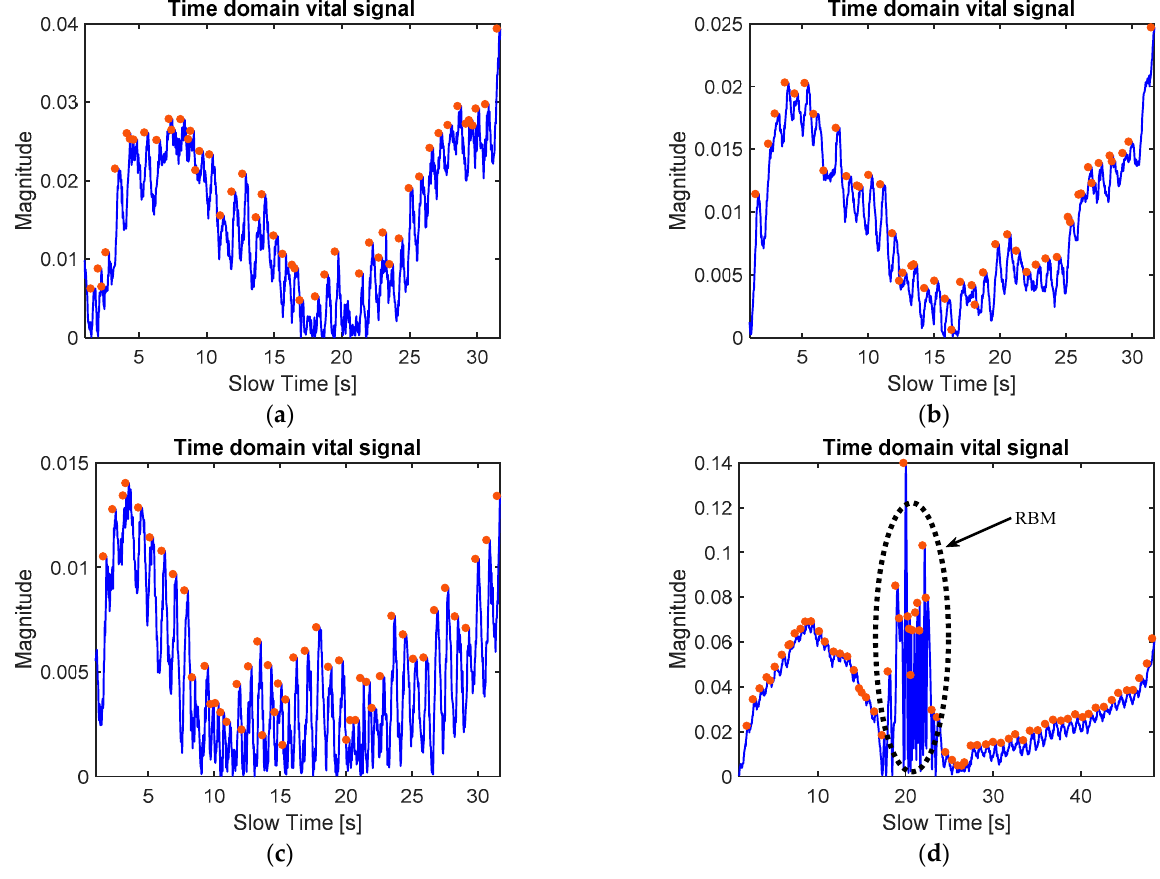
Figure 12. Vital signal obtained from multiple subjects. Normal resting position ( a – c ) and resting and RBM signal ( d